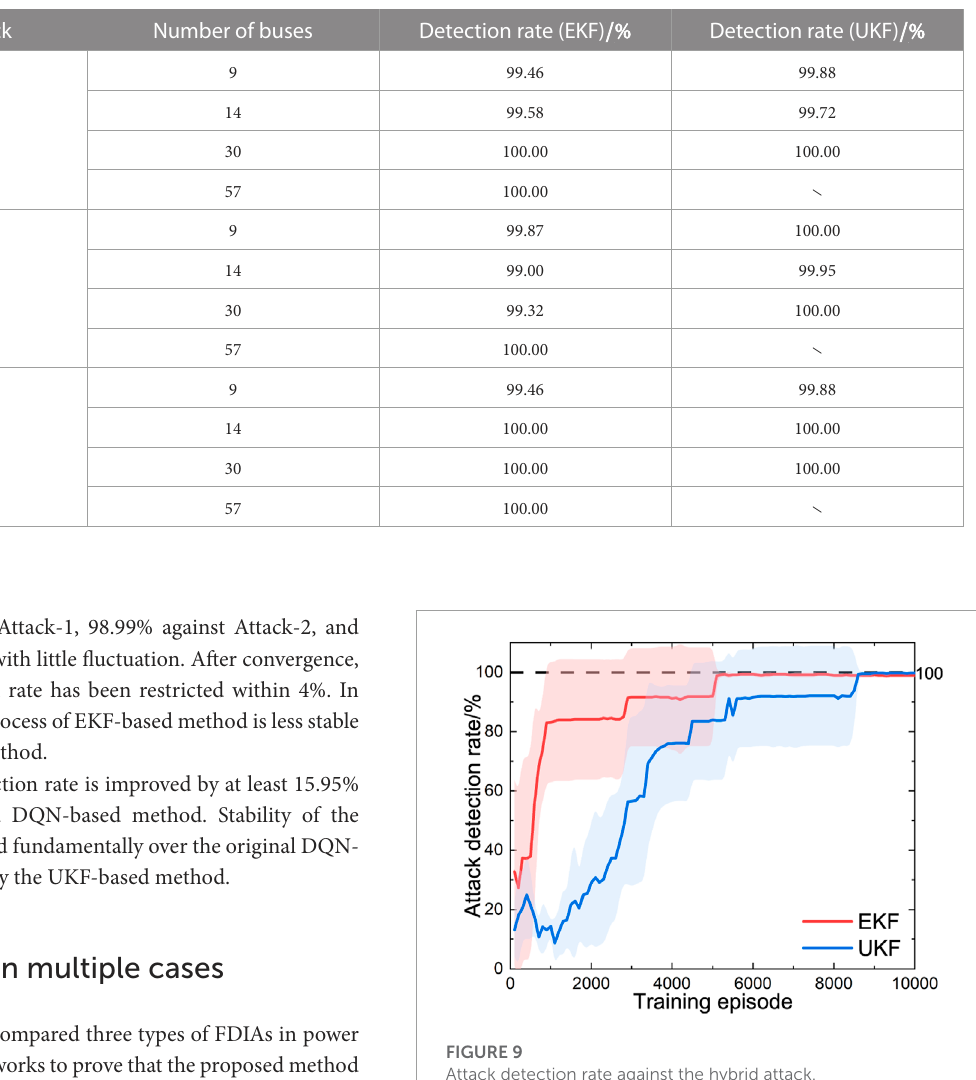
TABLE5 Performanceofdetectionindifferentsystemsagainstmultipleattacks.